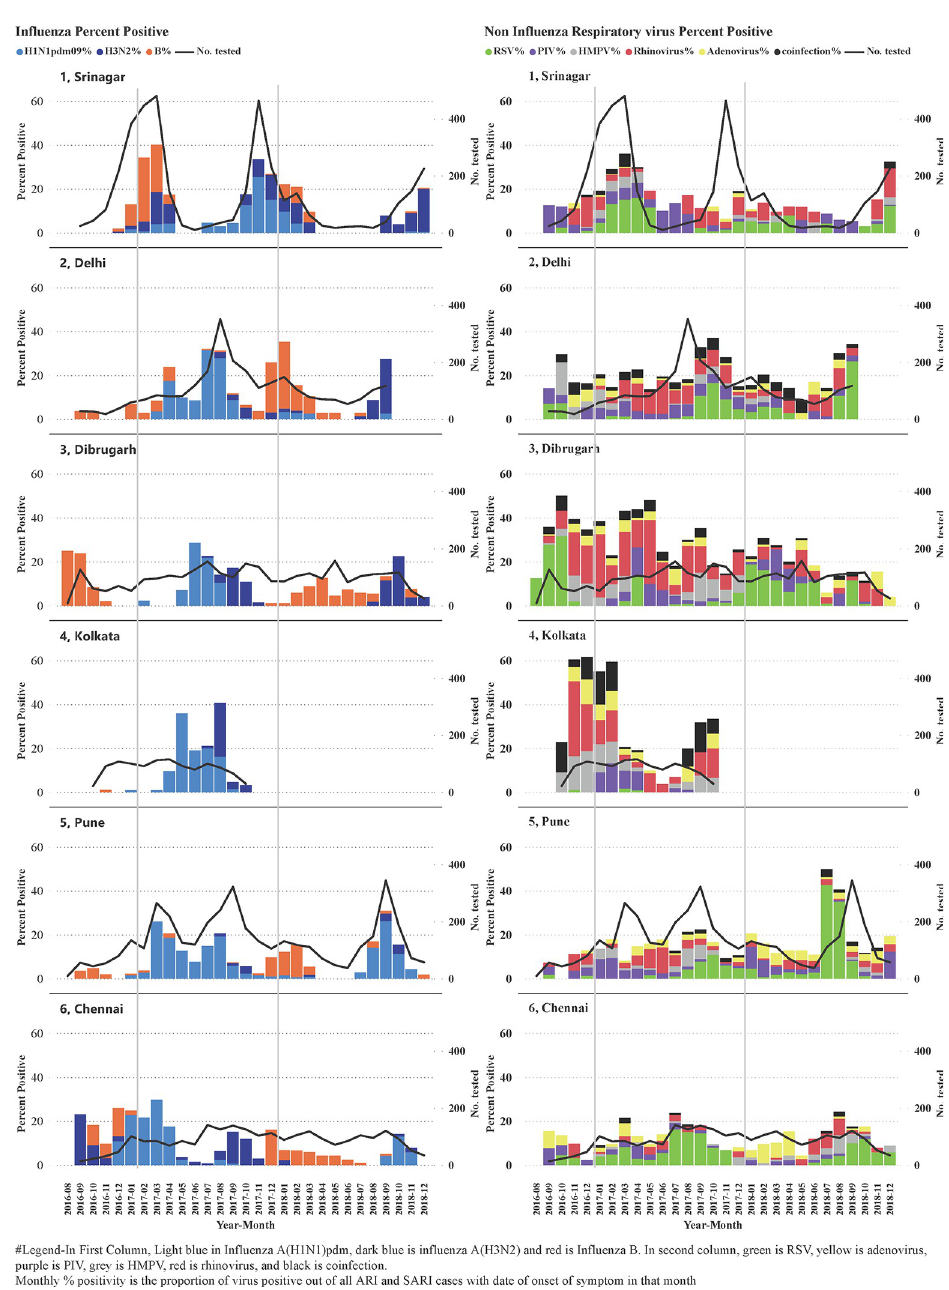
Fig 2. Monthly percent positivity of influenza and other respiratory viruses at different sites in India (2016–18).